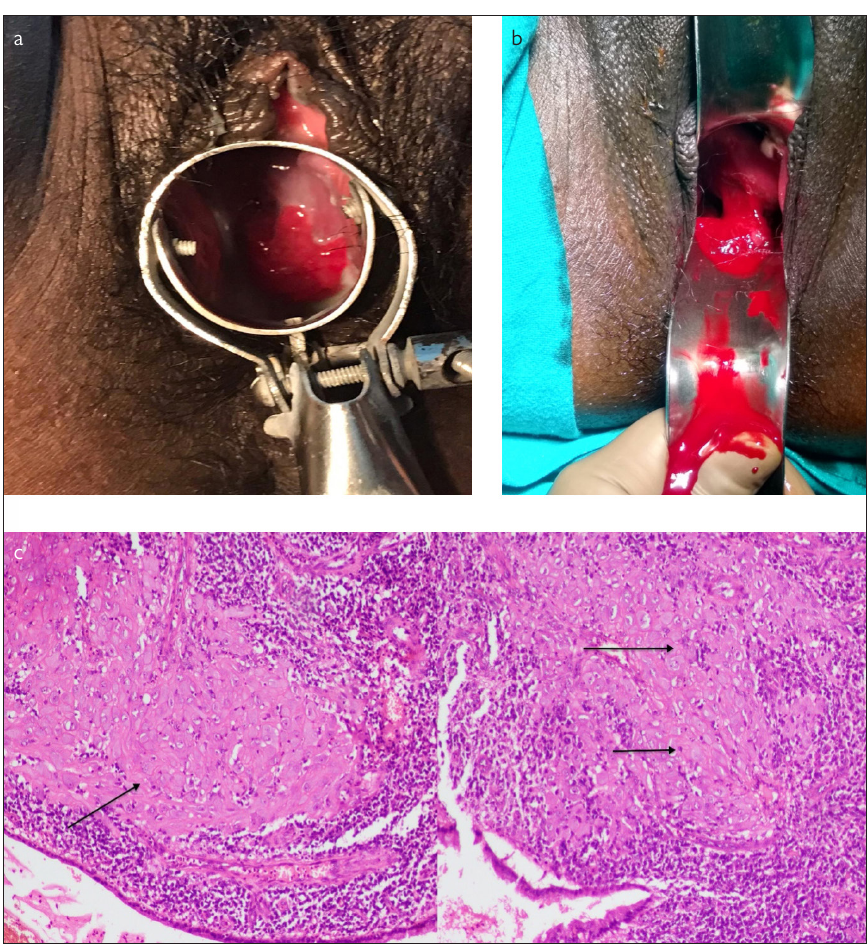
Figure 1. a-c. (a) Cervical polyp as seen at 20 weeks, causing spotting, managed conservatively, (b) Cervical Decidualised polyp at 24 weeks presenting with ante partum haemorrhage, (c) H&E:10x:10X: Sheets of decidualized tissue (arrow) surrounded by dense chronic inflammatory infiltrate in cervix (left), H&E:20X10X: Sheets of decidualized tissue (arrows) in cervix (Right) 249x269mm (144 x 144